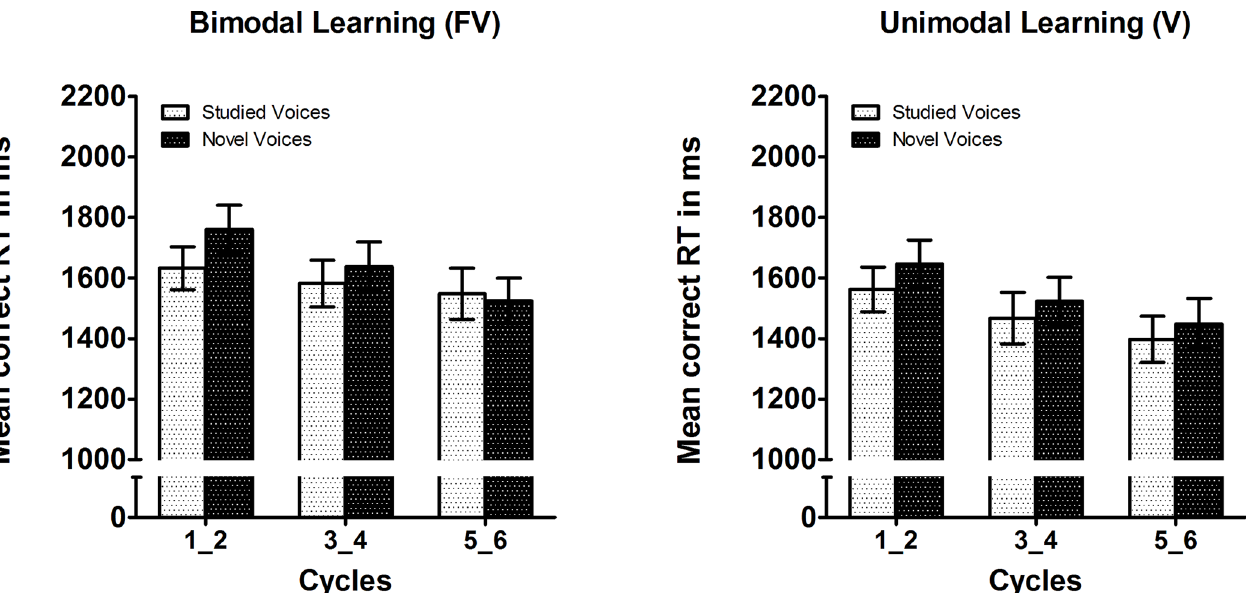
Fig 4. Mean correct reaction times to studied vs. novel voices depicted for pairs of consecutive study-test cycles following (left) bimodal face- voice learning and (right) unimodal voice-only learning. Note that data are collapsed across animation mode (static [Exp. 1] and dynamic [Exp. 2]). Error bars are